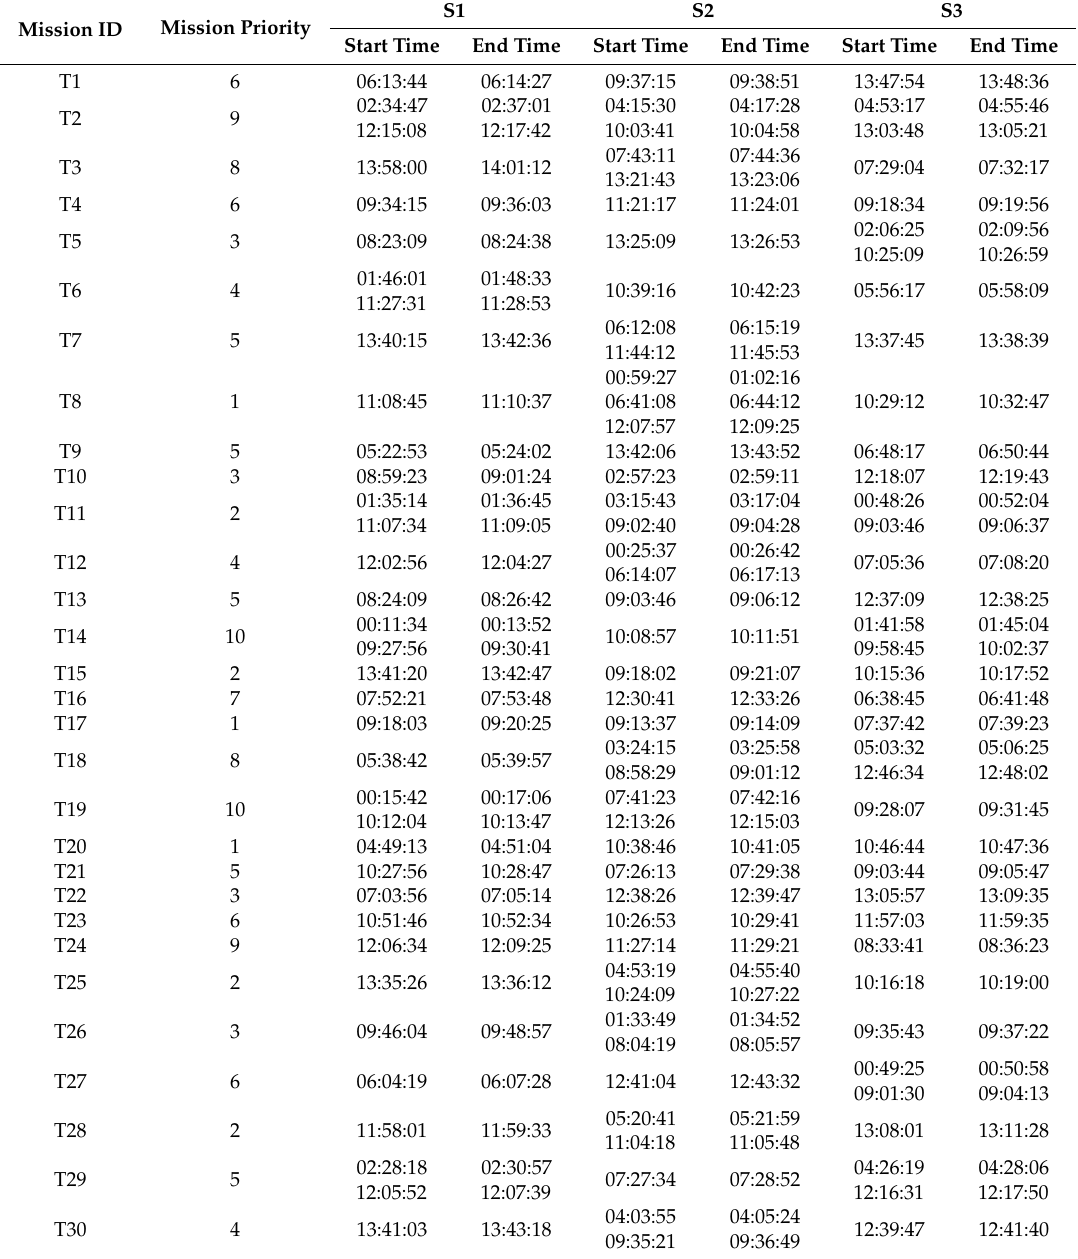
Table 10. Visible time window for the initial missions and new